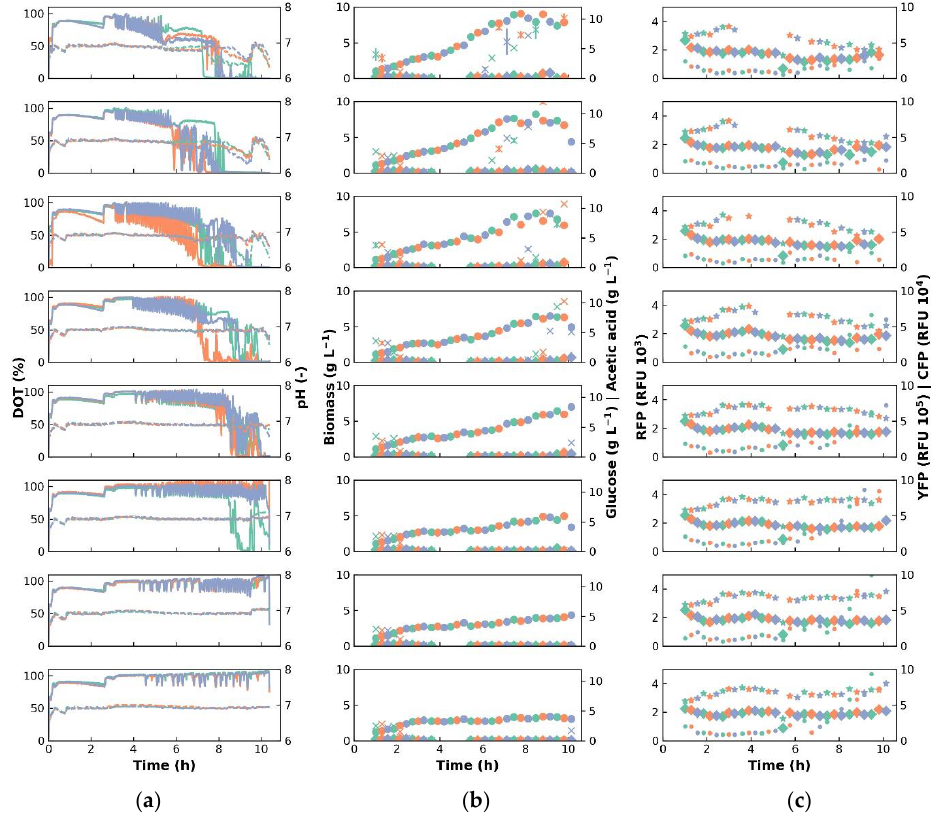
Figure 2. Cultivation data of the experiment. The rows represent a group of replicates with three mini- bioreactors (MBR). From top to bottom row, the applied feed decreased by 10% from 90% to 20% of µ max . ( a ) Solid lines: DOT (%); dashed lines: pH (-); ( b ) dots: biomass (g L −1 ); stars: glucose (g L −1 ); diamonds: acetic acid (g L −1 ); ( c ) dots: RFP (RFU × 10 3 ) ( rpsJ constitutive promoter); stars: YFP (RFU × 10 5 ) (inducible XylS/Pm promoter); diamonds: CFP (RFU × 10 4 ) (σ 32 related constitutive promoter).